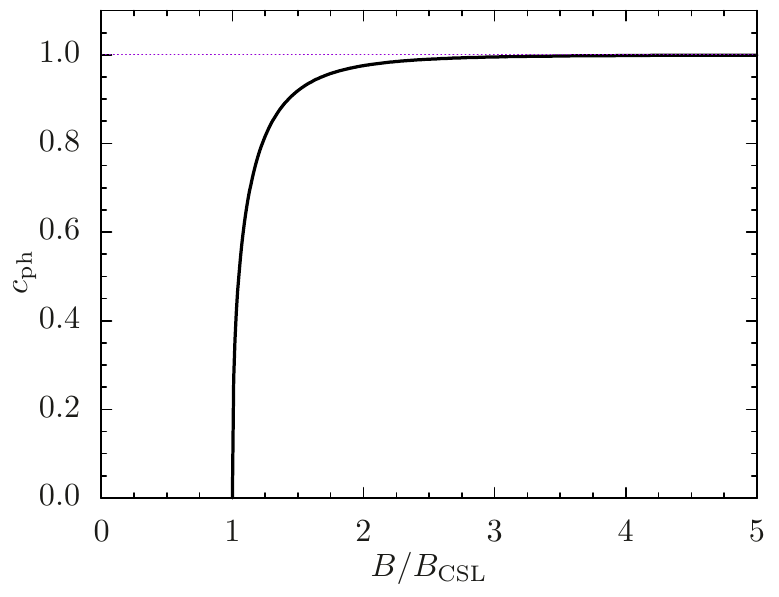
Figure 4 . Group velocity of the CSL phonon as a function of magnetic